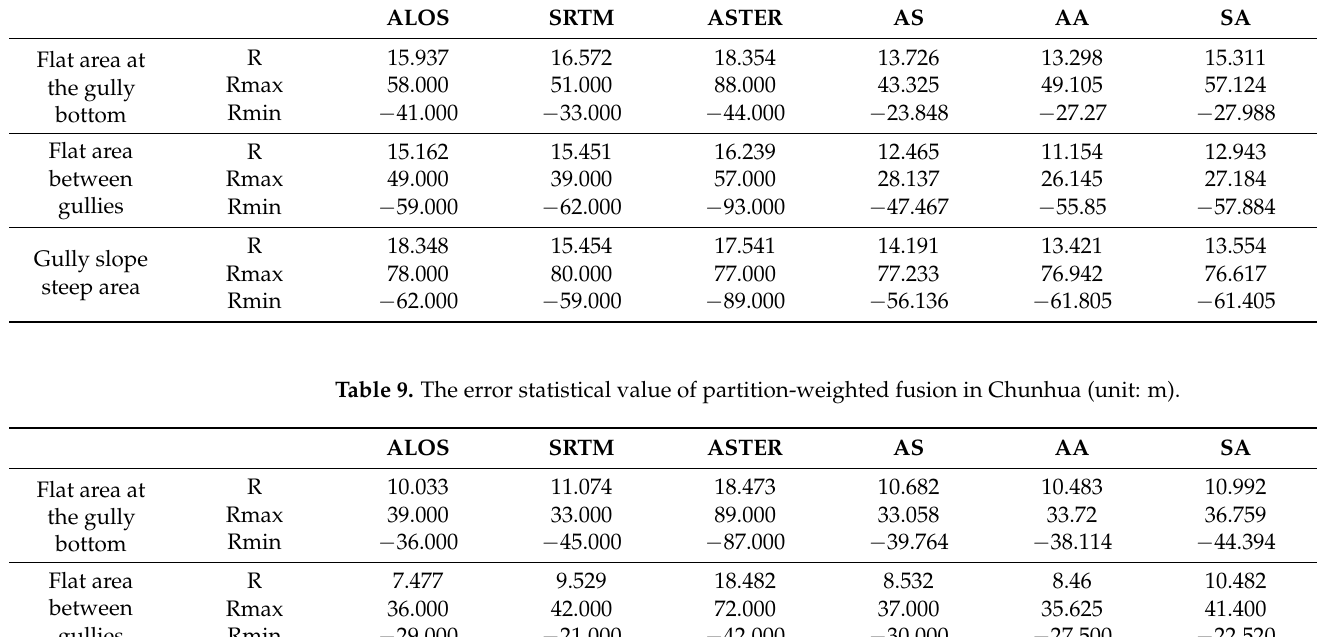
Table 8. The error statistical value of partition-weighted fusion in Yanchuan (unit: m). ALOS SRTM ASTER AS AA SA